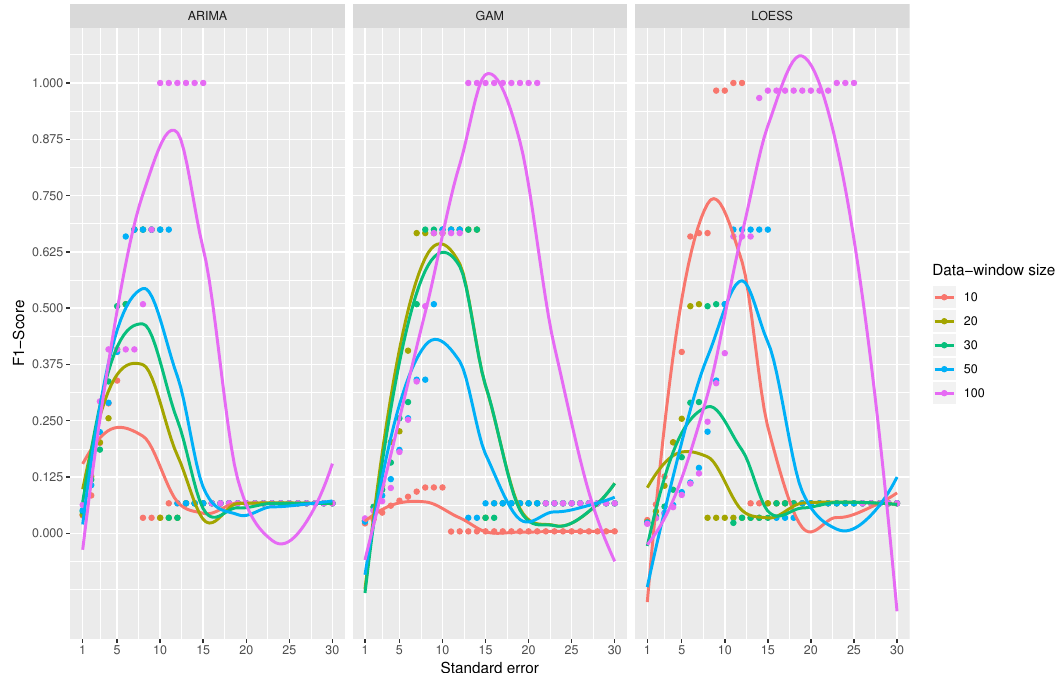
Figure 10. Comparison chart among functions, data-window sizes, and standard errors.